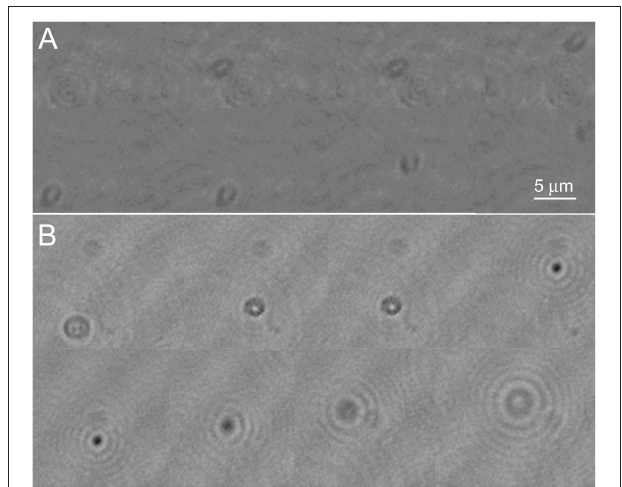
FIGURE 4 | Phase images of Vibrio alginolyticus swimming through x, y, and z. (A) No dye. (B) Labeled with NanoOrange. Displayed phase range is − pi to + pi. As in Figure 3 , the images are successive frames with 0.14s between each